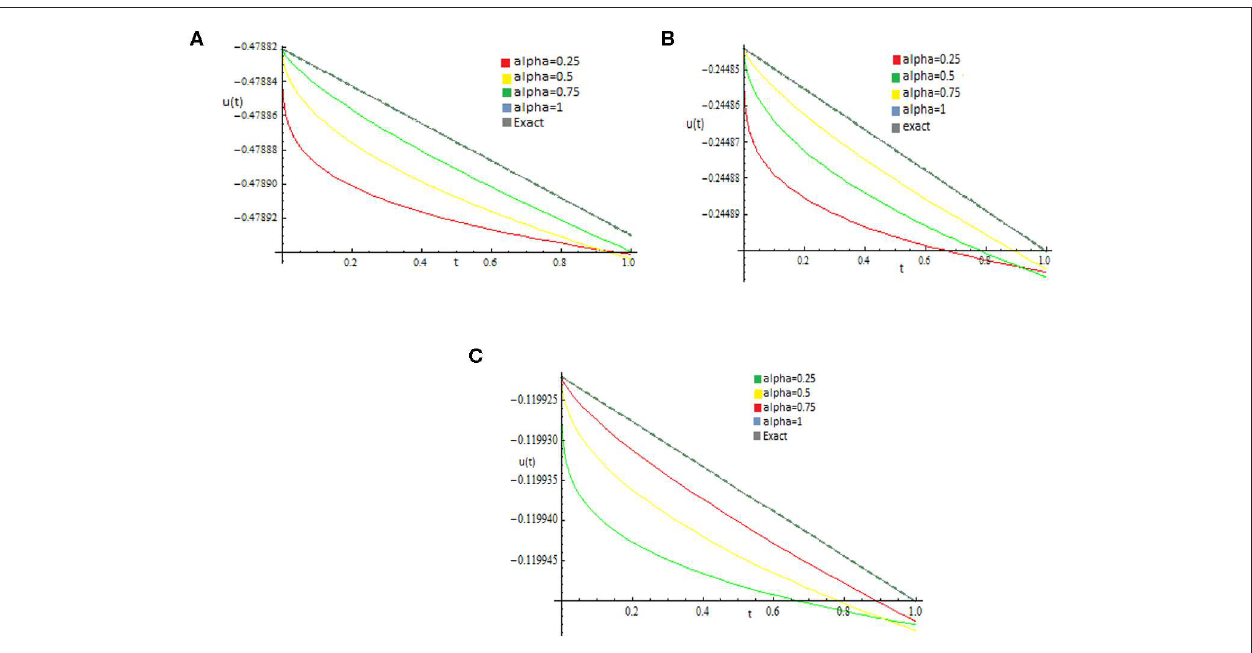
FIGURE 2 | 2D curves for u ( x , t ) part of (A) WBK equation, (B) MB equation, (C) ALW equation at x